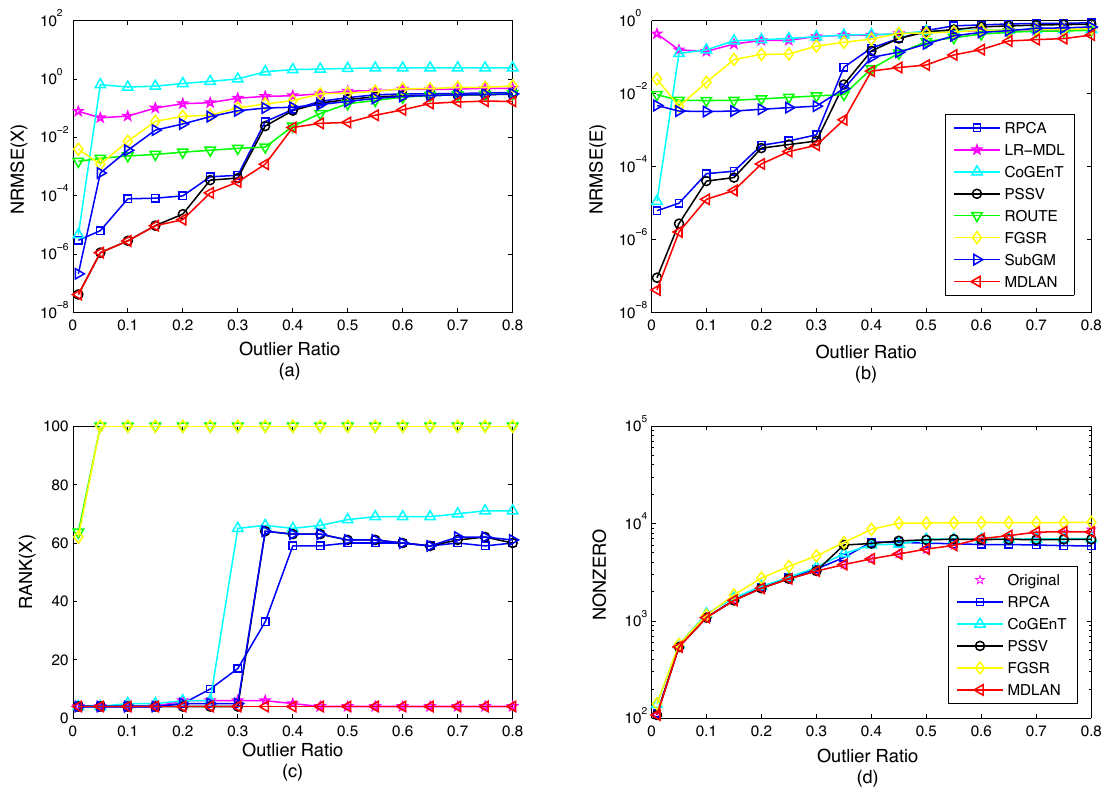
Figure 4. ( a ) Average normalized root mean square error (NRMSE) for the low-rank matrix, ( b ) average NRMSE for the sparse matrix, ( c ) the rank ( r ) of recovery for the low-rank matrix, ( d ) average number of nonzero entries of the recovered sparse